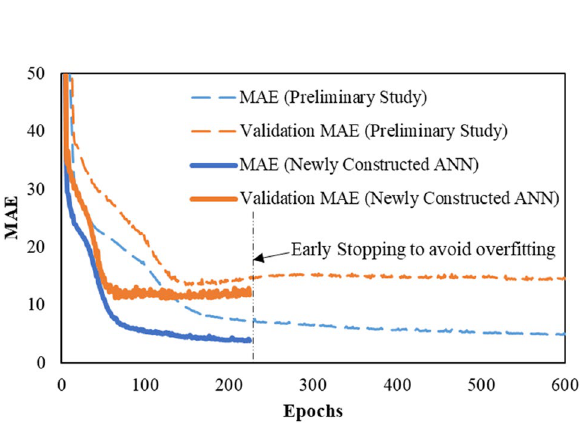
Figure 9. Comparison of the improved performance of the constructed